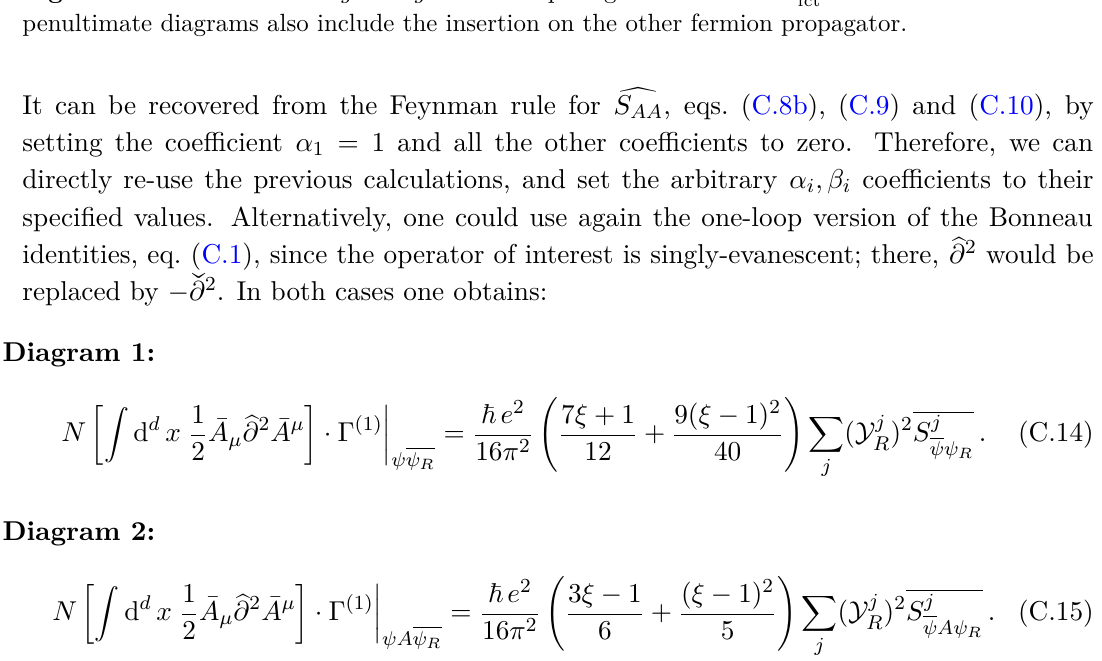
insertion. The first and fct